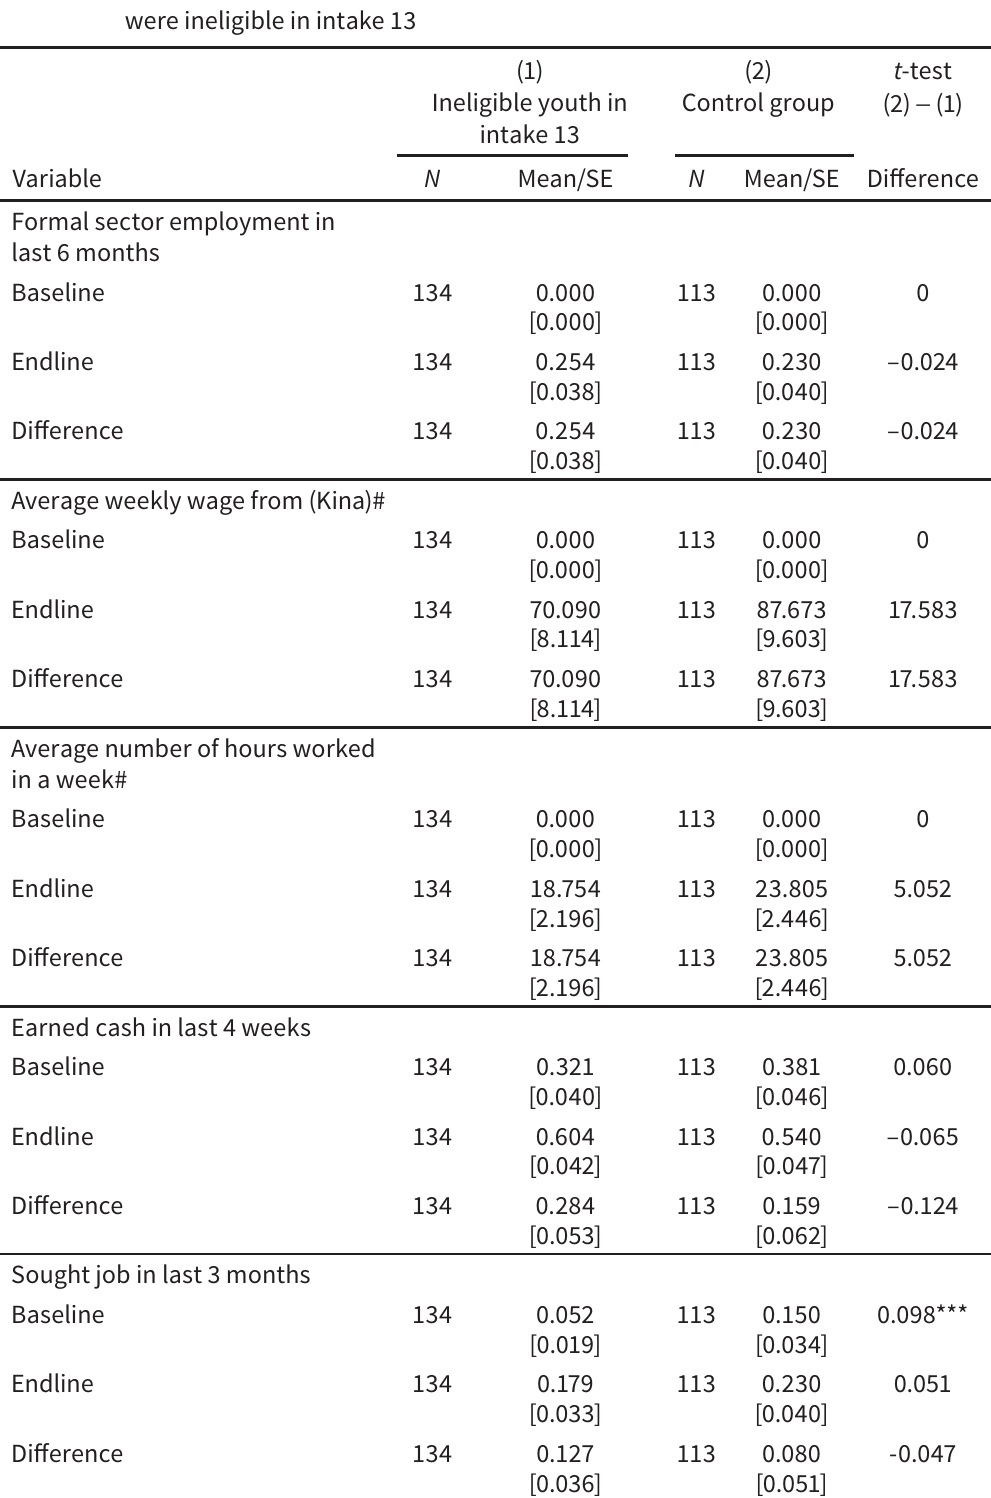
Table A5 Differences in outcomes between youth in the control group and youth who were ineligible in intake